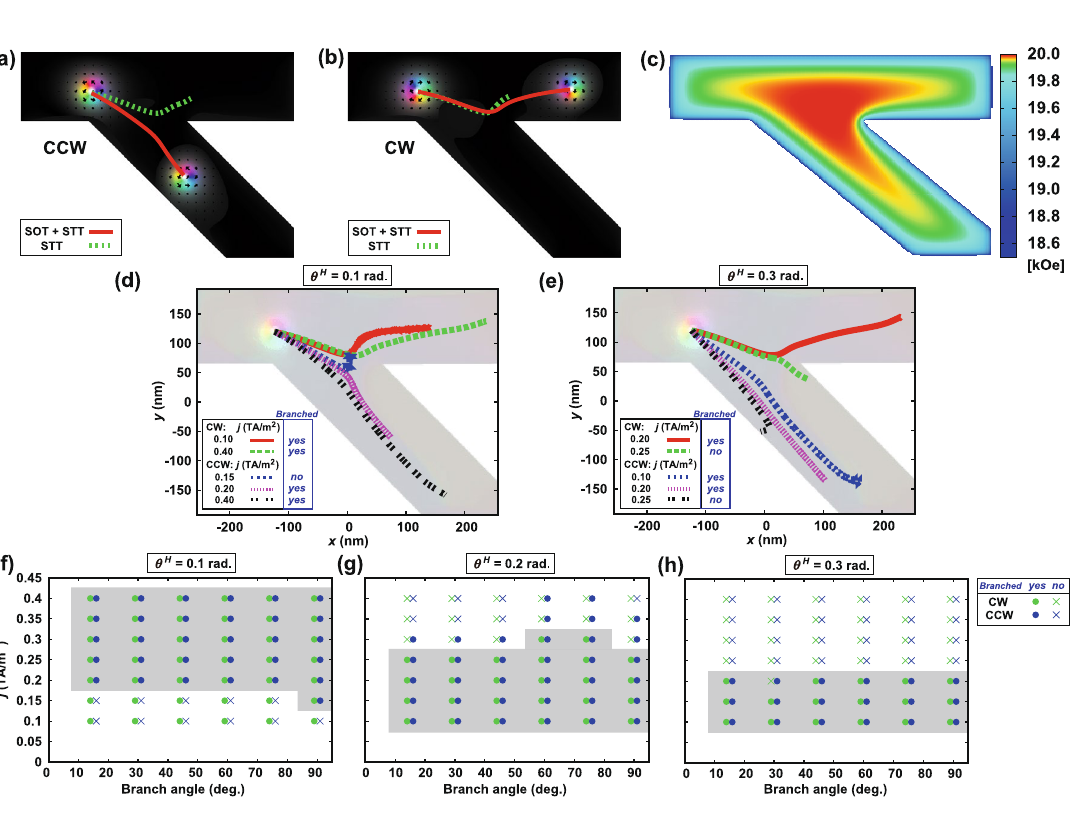
Figure 3. Motion of a skymion by SOT and STT. ( a , b ) Motion of a ( a ) CCW and ( b ) CW skymions by SOT and H = STT for 40 ns with the branch angle of 45º, j = 0.3 × 10 12 A/m 2 , P = 0.7, θ 0.1 rad (red lines). The green dashed H = lines show the cases without SOT ( θ 0 rad). ( c ) Distribution of the demagnetizing field at the branch. H = ( d , e ) Change of the skyrmion motion by the current density and spin Hall angle θ ( d ) 0.1 and ( e ) 0.3 rad. “Branched no” shows the cases for unbranch and a skyrmion crashed at the strip edge or branch center. ( f – h ) Phase diagrams of the branch. The branch angle was varied from 15 to 90º, and the current was varied from 0.1 H = to 0.4 TA/m 2 . The spin Hall angles are θ ( f ) 0.1, ( g ) 0.2 and ( h ) 0.3 rad. Circles show the branched cases, and the crosses show the unbranched cases. Green (blue) symbols represent the CW (CCW) skyrmion cases. Shaded area shows the angle and current ranges of the main branch to be achieved for the both types of